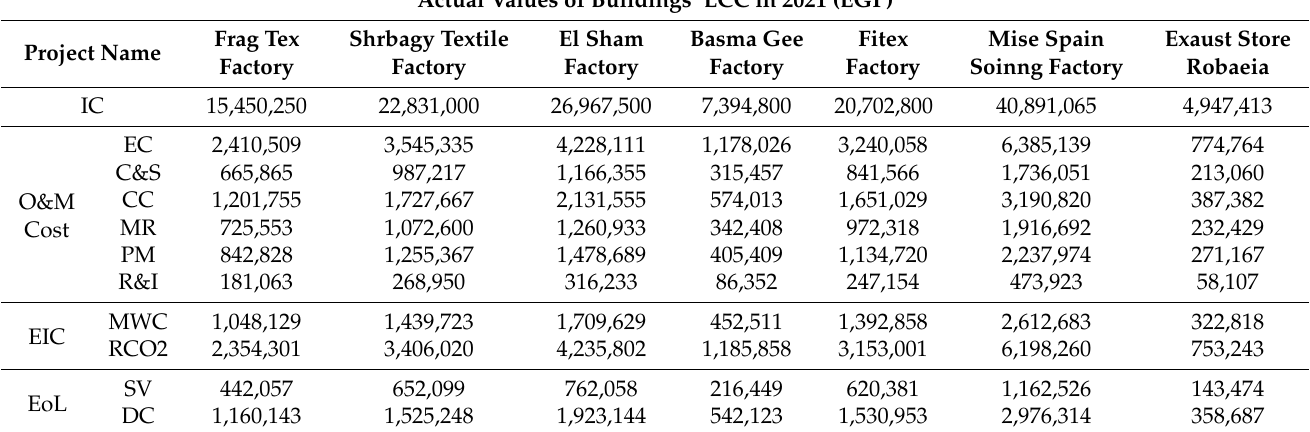
Table 5. Actual LCC of the case studies in 2021 (L.E). Actual Values of Buildings’ LCC in 2021 (EGP)